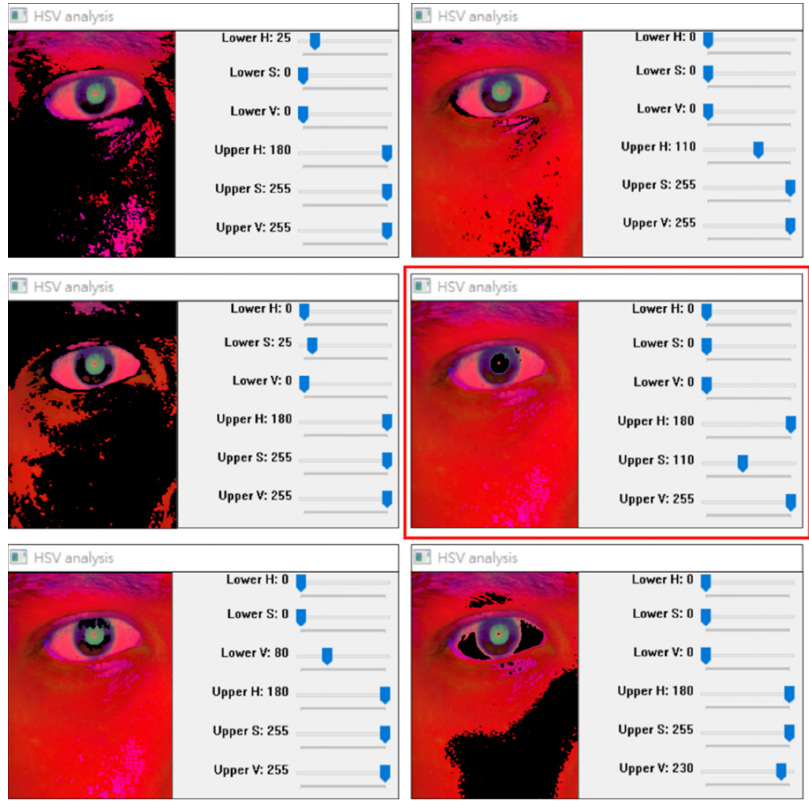
Figure 35. Adjustment of the color of each channel threshold mark.